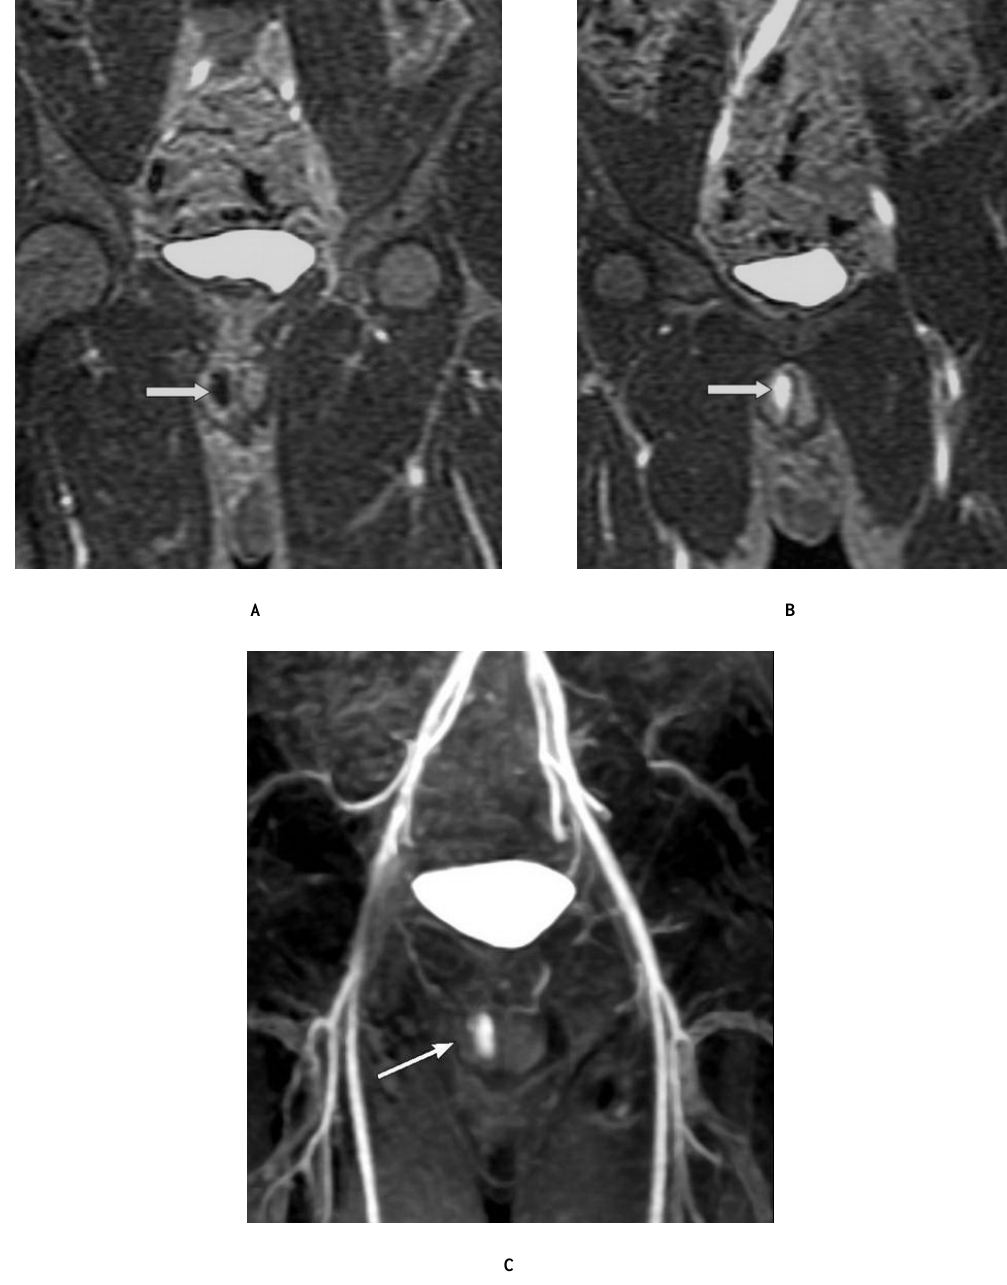
FIGURE 2. Right cavernosal artery pseudoaneurysm. (A) Gd-MRA of the penis showing a hypointense saccular lesion at the right corpus cavernosum (arrow) at the early arterial phase; (B) at the venous phase, there is filling of the pseudoaneurysm (arrow); (C) at the reformatted MIP image, the relation of the pseudoaneurysm (arrow) with the cavernosal artery could be delineated.